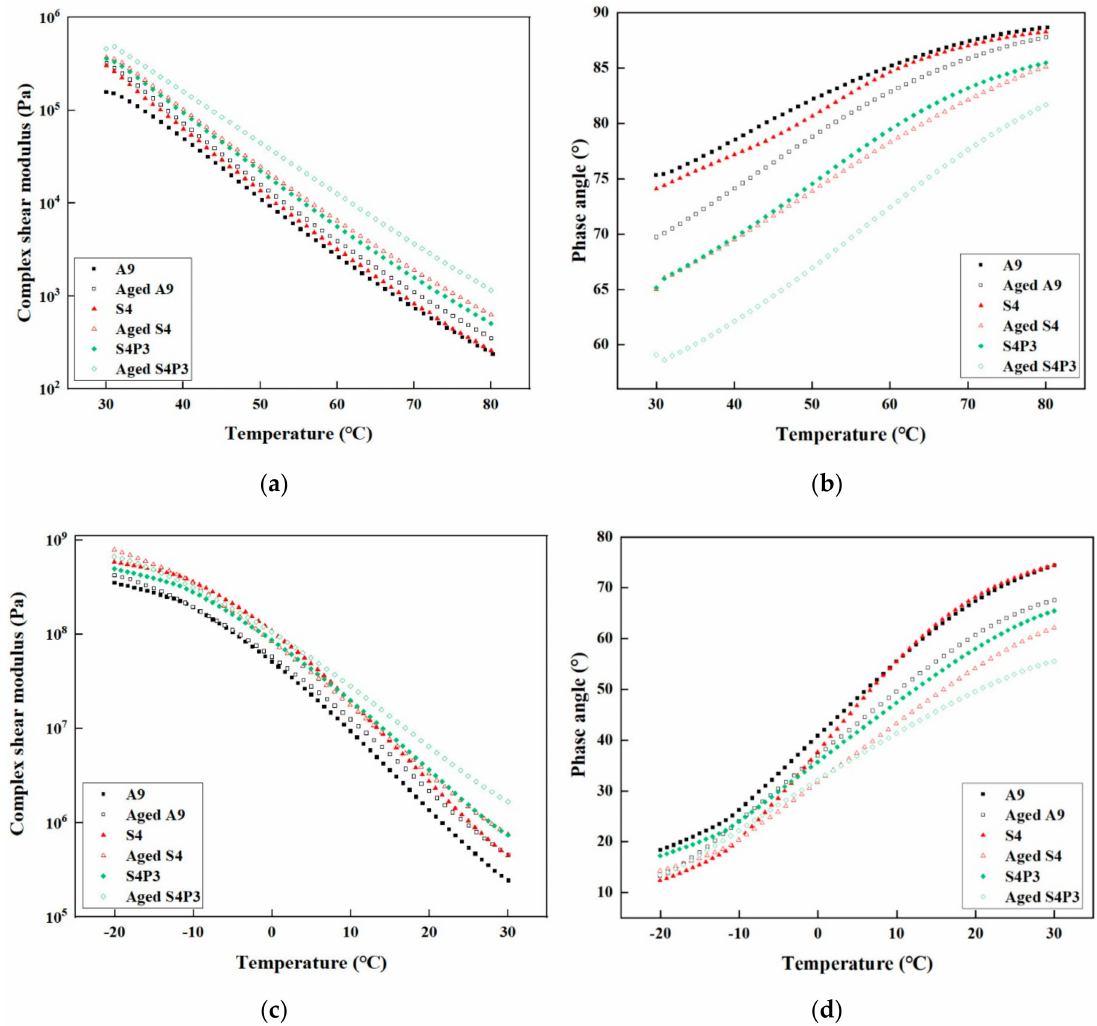
Figure 2. Rheological properties of asphalt binders before and after aging. ( a , b ) From 30 to 80 ◦ C; ( c , d ) from − 20 to 30 ◦